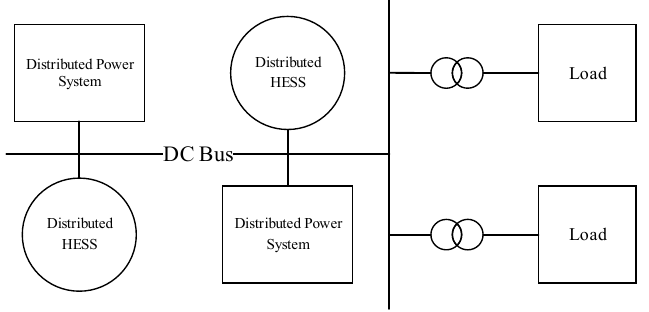
Figure 1. Schematic diagram of megawatt level microgrid structure.